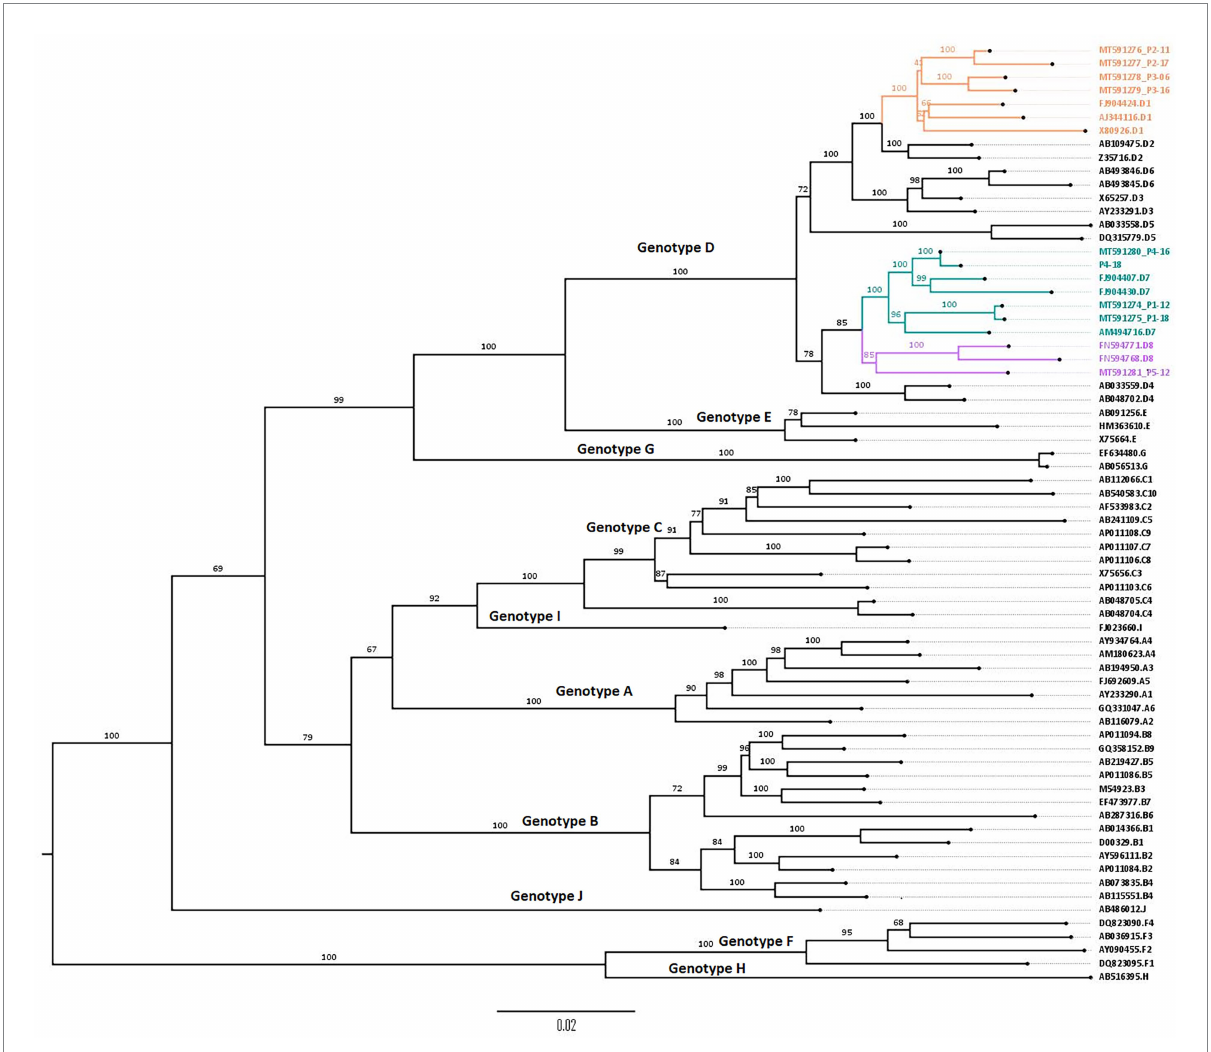
FIGURE 2 Phylogenetic tree constructed using the maximum likelihood method, showing D1, D7, and D8 subgenotypes from 5 Tunisian HBV patients. Phylogenetic tree of obtained genomic sequences with 58 reference sequences representing the 10 HBV genotypes (A–J) and their corresponding subgenotypes. The tree was constructed using the maximum likelihood method using the IQ tree web server and visualized by FigTree. Topology was supported by 1,000 bootstrap replicates. The tree was rooted using the midpoint rooting